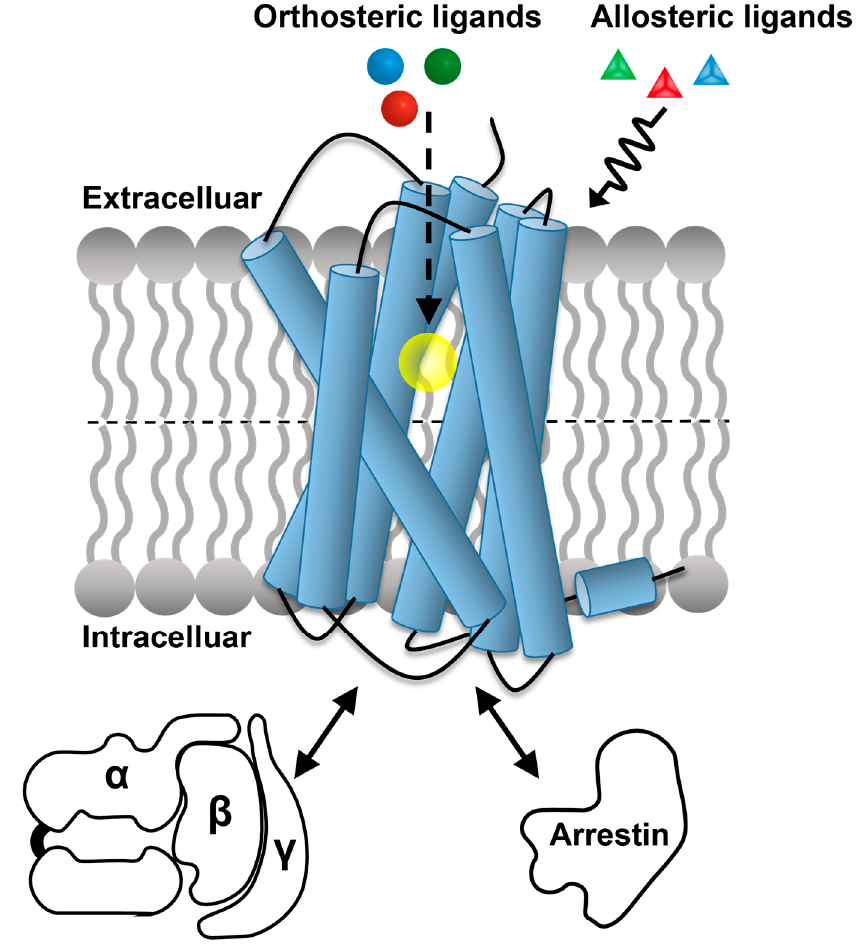
Figure 1. Overview of the intermolecular interactions involved in cellular signaling by GPCRs. The orthosteric binding pocket (indicated as a yellow ball) is usually targeted by endogenous ligands (indicated as small colored balls), which interact with the orthosteric binding pocket; they alter the activation state of the receptors according to their efficacy as full agonists, partial agonists, antagonists or inverse agonists. Allosteric ligands (indicated as triangles) typically bind to sites that are spatially distinct from the orthosteric binding pocket and modulate the affinity and/or efficacy of the ligand bound to the orthosteric site. Representative intracellular interaction partners of GPCRs are heterotrimeric G proteins ( α , β , γ ) and arrestins. Biased GPCR ligands preferentially activate either the G protein or the arrestin signaling pathways. (Adapted from Figure 2 in reference [12]).